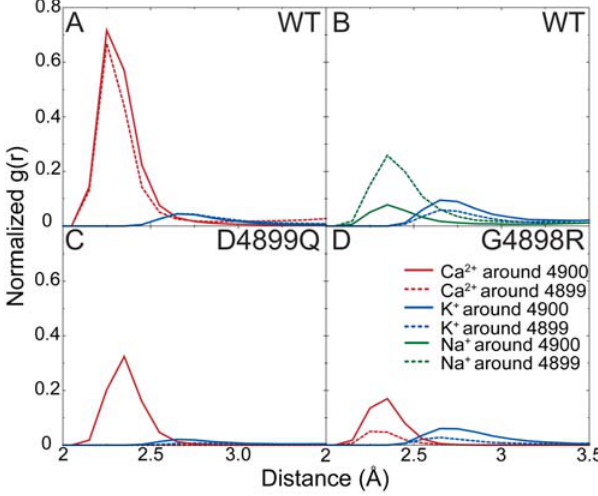
Figure 4. Radial distribution function (RDF) of ions around the carbonyl oxygens of 4899 and 4900. (A) RyR1-WT in 250 mM KCl and 70 mM CaCl 2 . (B) RyR1-WT in 250 mM KCl and 70 mM NaCl. (C) RyR1-D4899Q in 250 mM KCl and 70 mM CaCl 2 . (D) RyR1-G4898R in 250 mM KCl and 70 mM CaCl 2 . The plots represent distribution of the number of ions at a distance r from the centre of the carboxyl groups (amide group in Q) of D4899 and E4900. The graph axis starts at 2 A˚ and the peak occurs at the sum of van der Waal’s radii of oxygen and the ion. The average occupancy from 4 simulations is plotted.